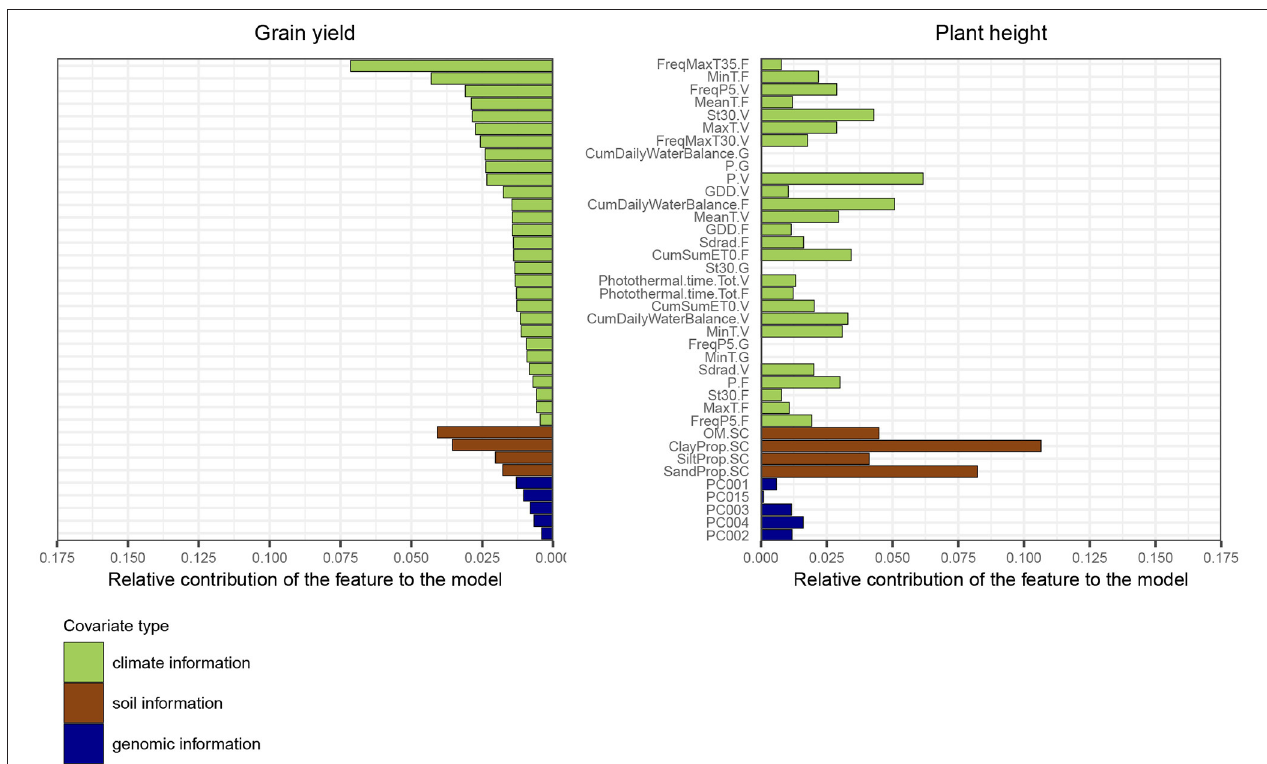
FIGURE 6 | Feature importance ranking based on the average relative gain per feature obtained with the model XGBoost-G+W, for the two traits grain yield and plant height. The metric was estimated using a model fitted on the full dataset. The gain represents the improvement in accuracy when using a feature for splitting, across all trees in the model. The order of features is based on feature performance within covariate class for the trait grain yield. The sum of all feature contributions is equal to 1. Weather-based variables from the grain filling stage were not used to predict plant